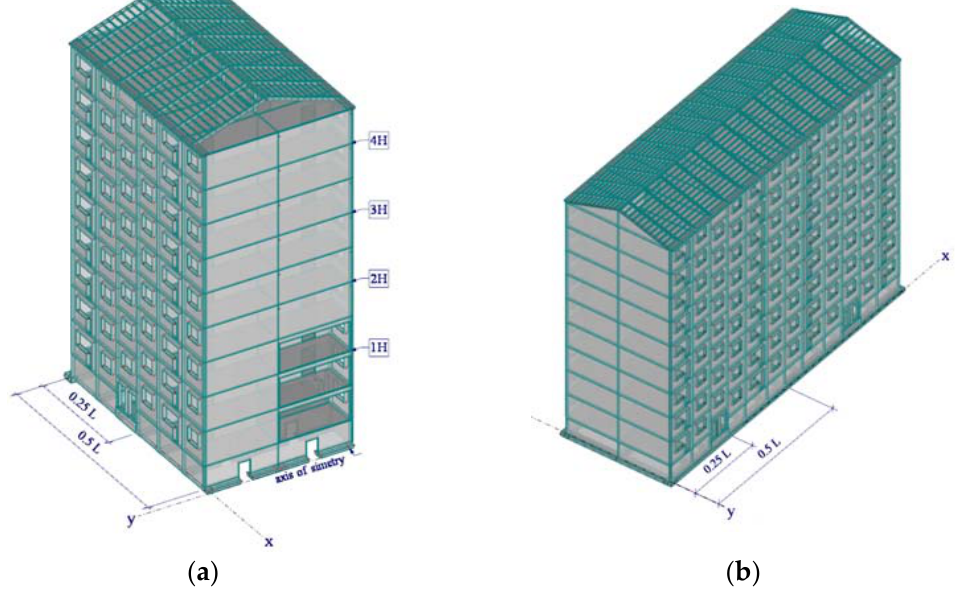
Figure 6. Damage locations for the reference model #1: ( a ) building section; ( b ) FE model of the building.